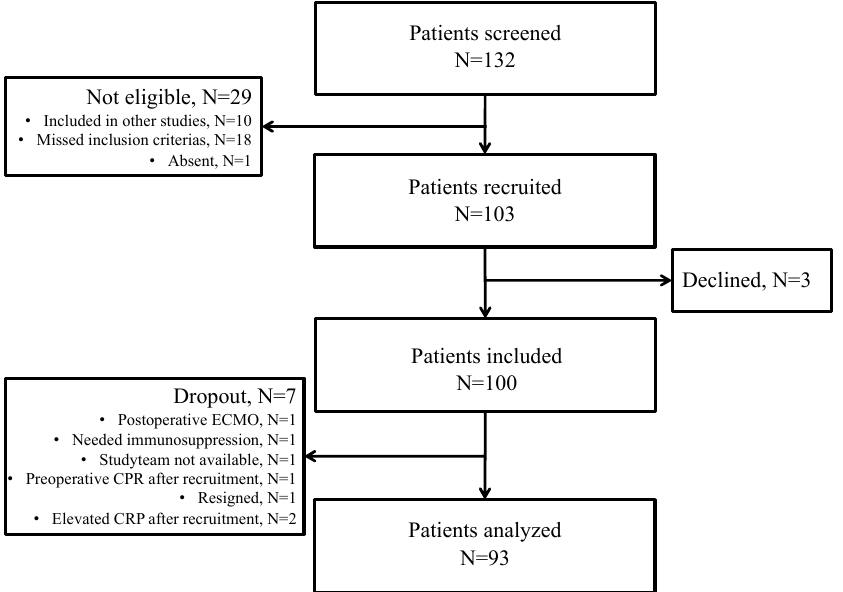
Figure 1. Selection and exclusion criteria for patients enrolled to the study.